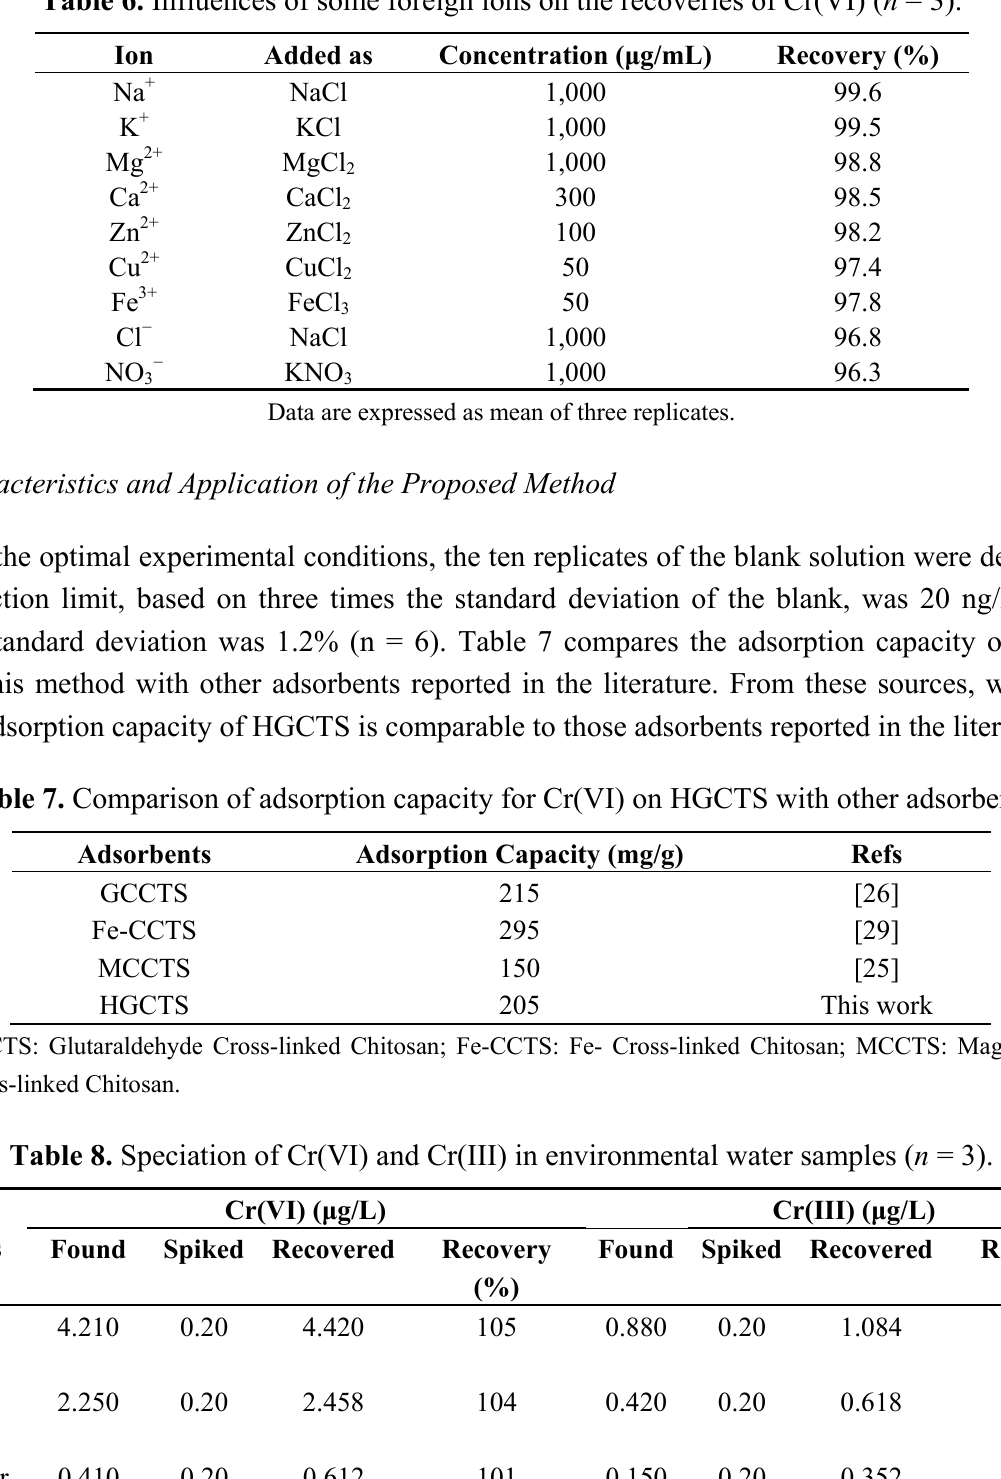
Table 6. Influences of some foreign ions on the recoveries of Cr(VI) ( n = 3).